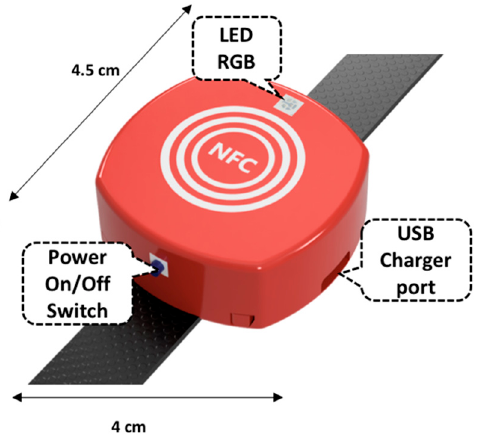
Figure 10. MovED physical design.